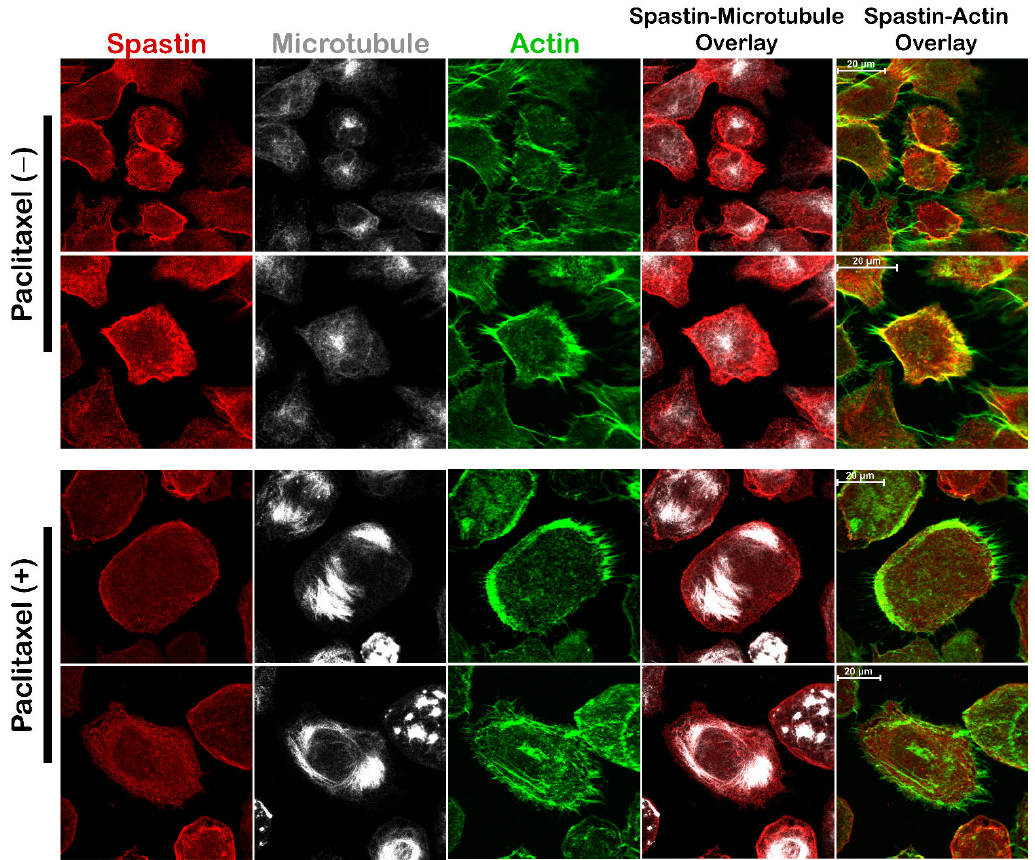
Figure 8. Spastin could not be directed to actin filaments upon microtubule stabilization. T98G cells were treated with EGF for 24 h and with paclitaxel (Paclitaxel (+); lower panel) for 18 h, and the cells which were stimulated with only EGF were used as controls (Paclitaxel ( − ); upper panel). After treatments, cells were fixed with mixed ‐ aldehyde and stained with Spastin antibody (red), tubulin antibody for microtubule (gray), and phallacidin for actin filaments (green).